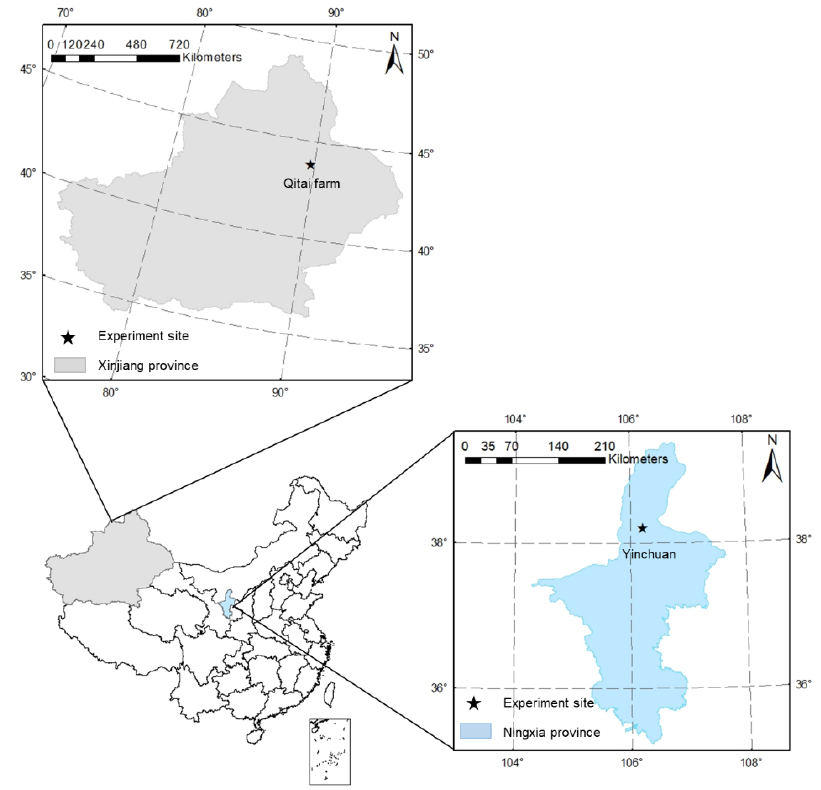
Figure 1. The positions of two experimental